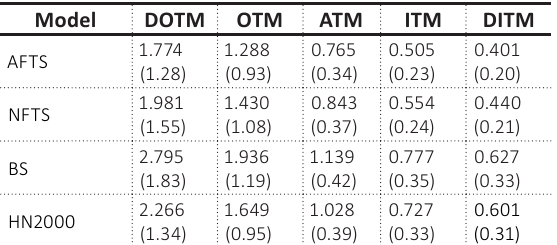
Table 4. Out-of-sample forecast errors as a function of